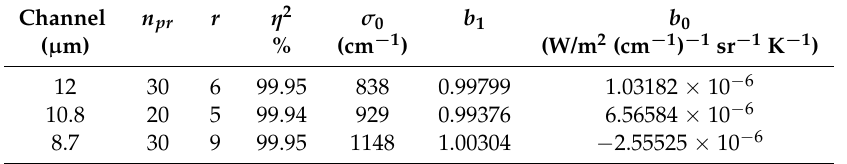
Table 2. The table summarizes the number of predictors in radiance space ( n pr ), principal components space ( r ) and the variance explained in percentage units ( η 2 ). The coefficients b 0 , b 1 are also shown.